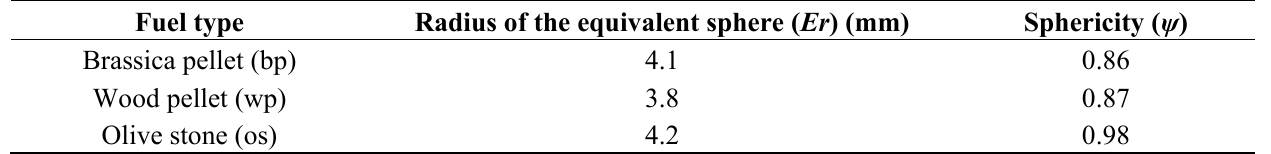
Table 2. Fuel morphology